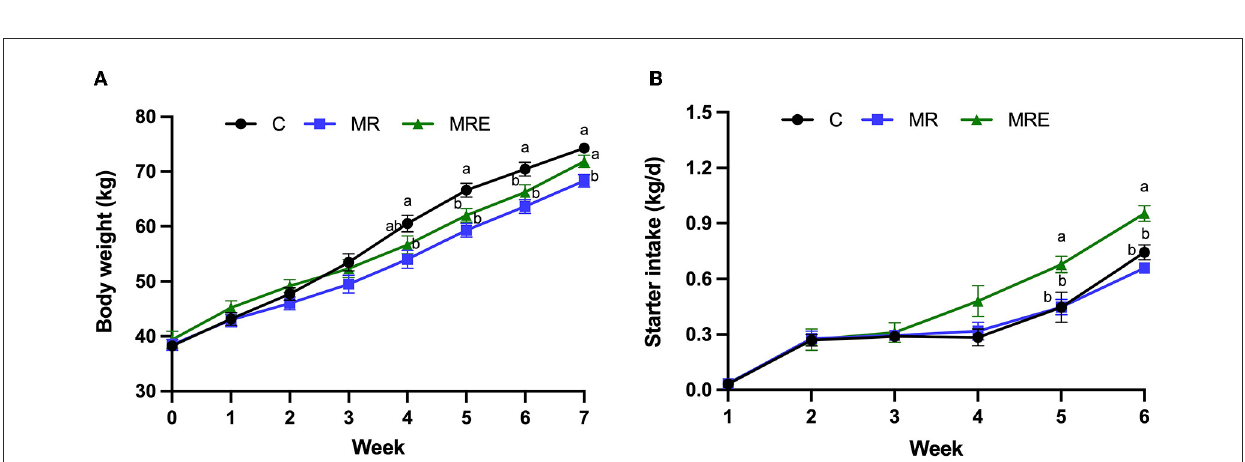
FIGURE2 Growth performance of Holstein calves. C, calves fed fresh milk; MR, calves fed milk replacer; MRE, calves fed milk replacer plus ethoxyquin. (A) Body weight; (B) Starter pellets intake. Values were means ± SEM. ab The mean values with different superscripts are different at P < 0.05. N = 11.9, and 11 in C, MR, and MRE, respectively.